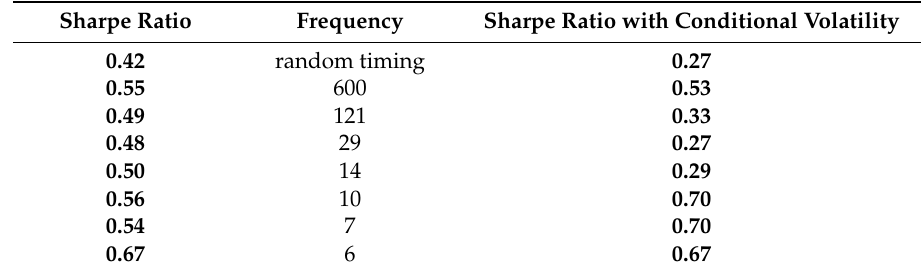
Table 7. Rolling window of 600 trading days, Sharpe ratios, data frequencies, and Sharpe ratios with conditional volatilities (bold denotes significance).